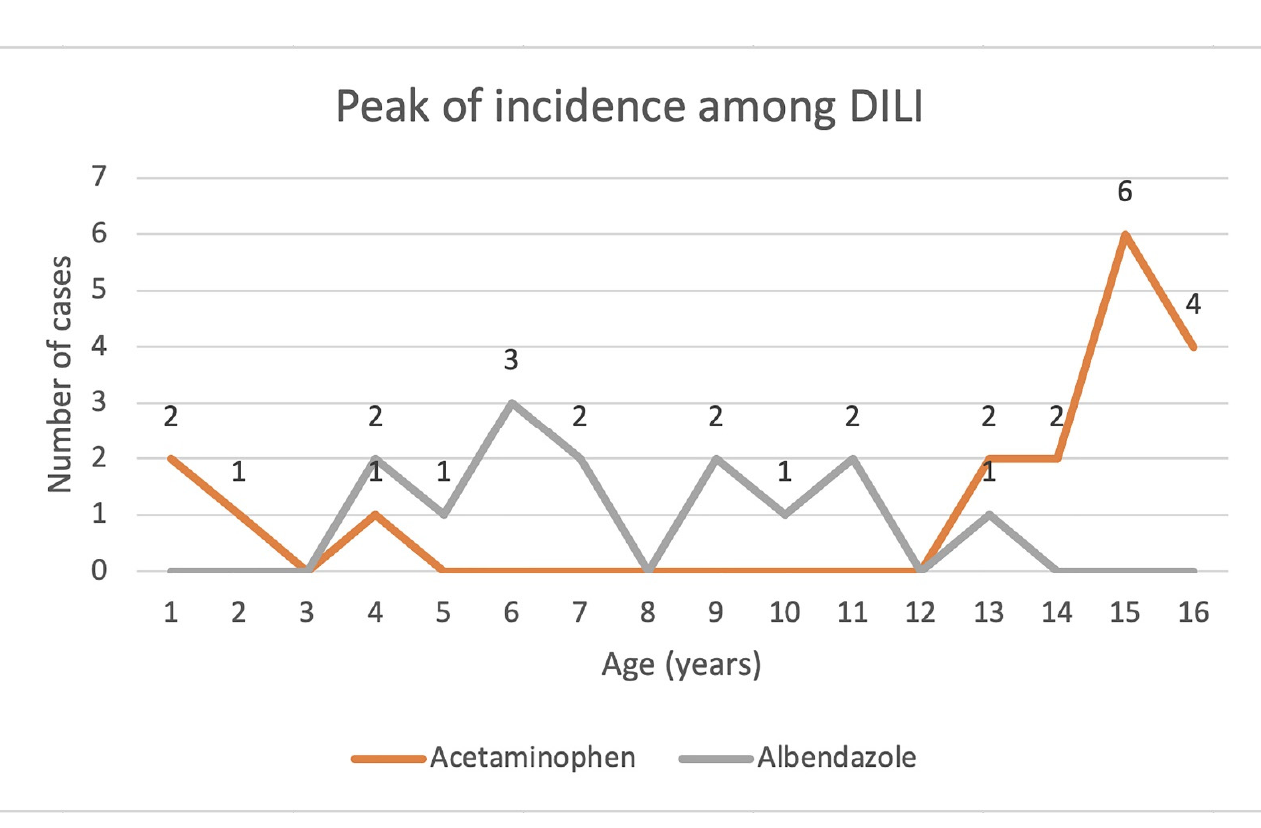
Figure 2. Peak of incidence among DILI patients.